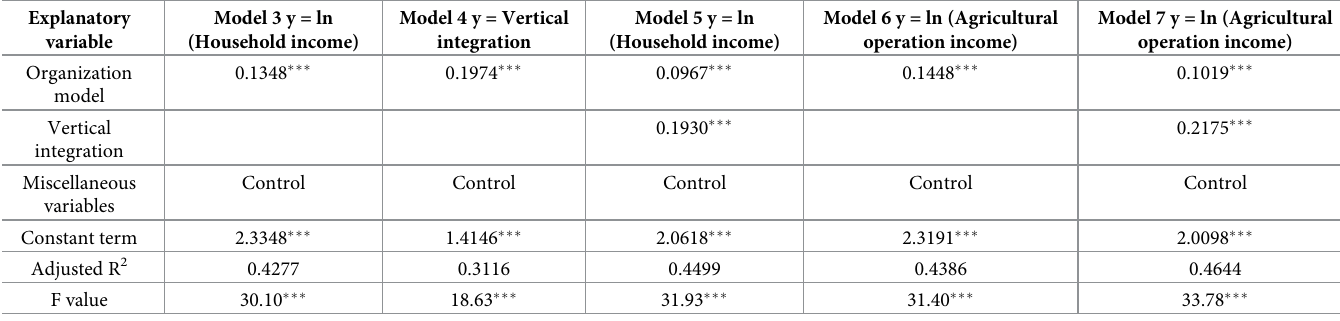
Table 4. Mediation effect test between vertical integration and organizational model and total household income and agricultural